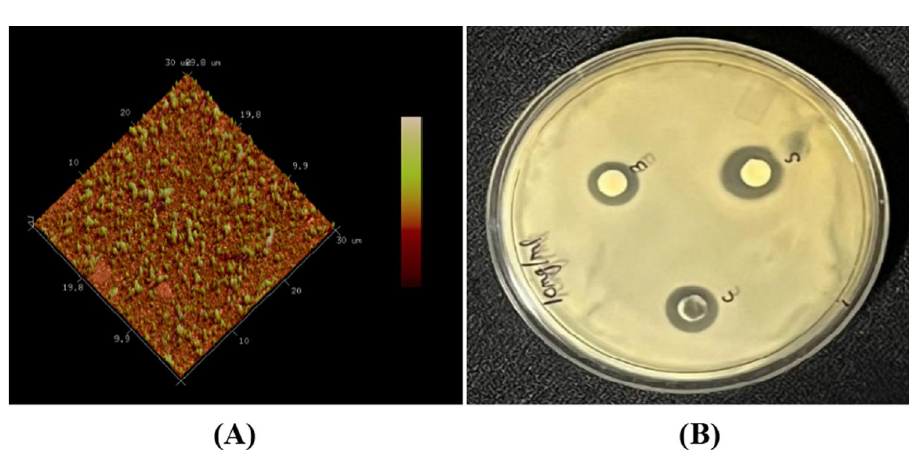
Figure 4. SEM and EDX of cow dung extract mediated biologically synthesized nanoparticles.